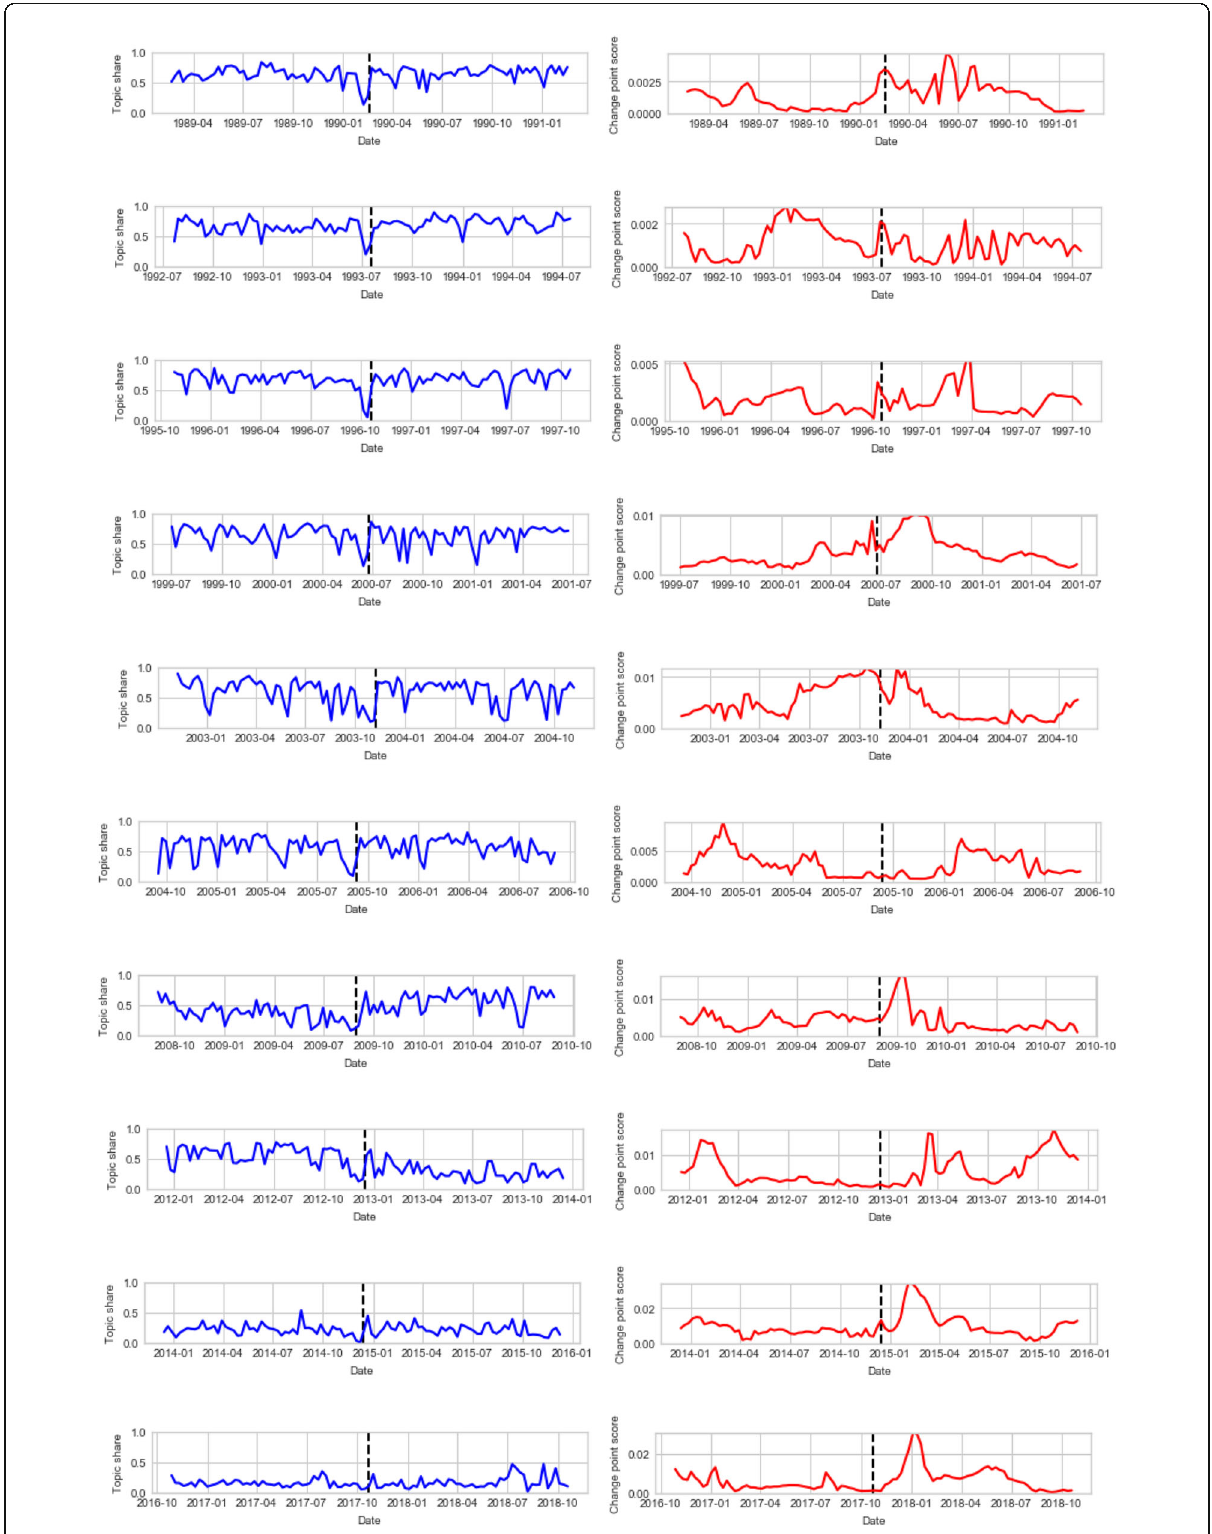
Fig. 15 Topic Share and Change Point Scores of all Lower House Elections from 1986 to